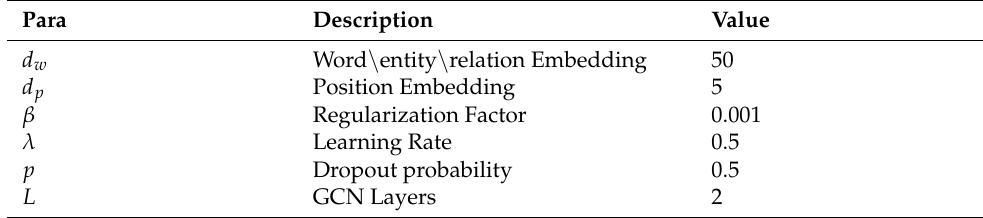
Table 2. Hyper-parameters used in our experiments.